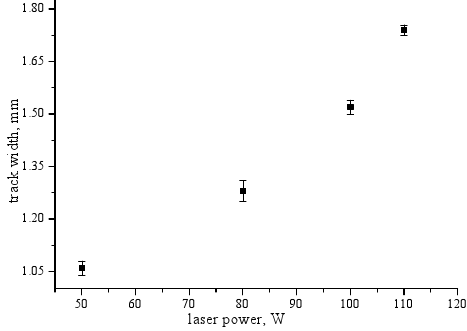
Figure 5. Width of cladded tracks from alumel feedstock as a function of the laser power. Common parameters: v S = 400 mm/min, d S = 0.984 mm, f F = 1.7 g/min, f C = f P = 10 L/min.